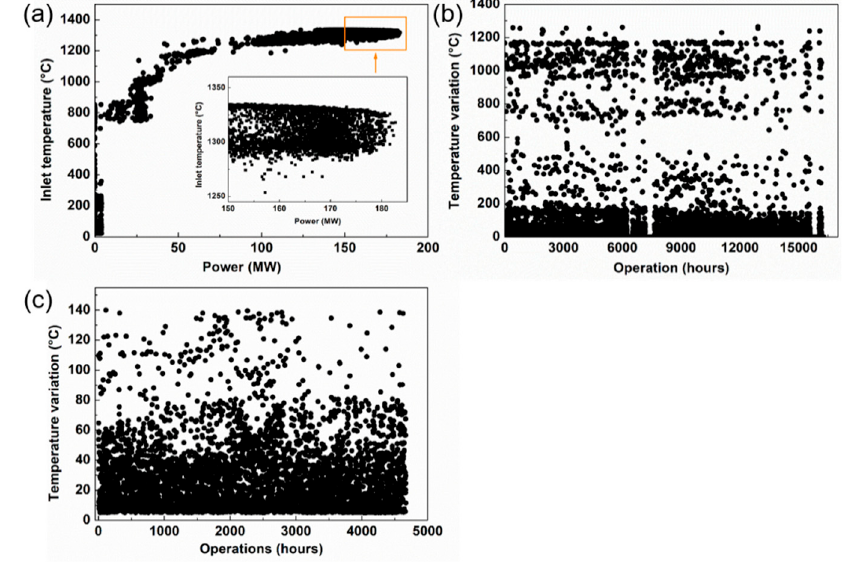
Figure 6. The temperature variation during operation: ( a ) The inlet temperature of a gas turbine against the generated power, ( b ) the variations of the inlet temperature during the entire operation, and ( c ) the variations of the inlet temperature during a steady-state operation.